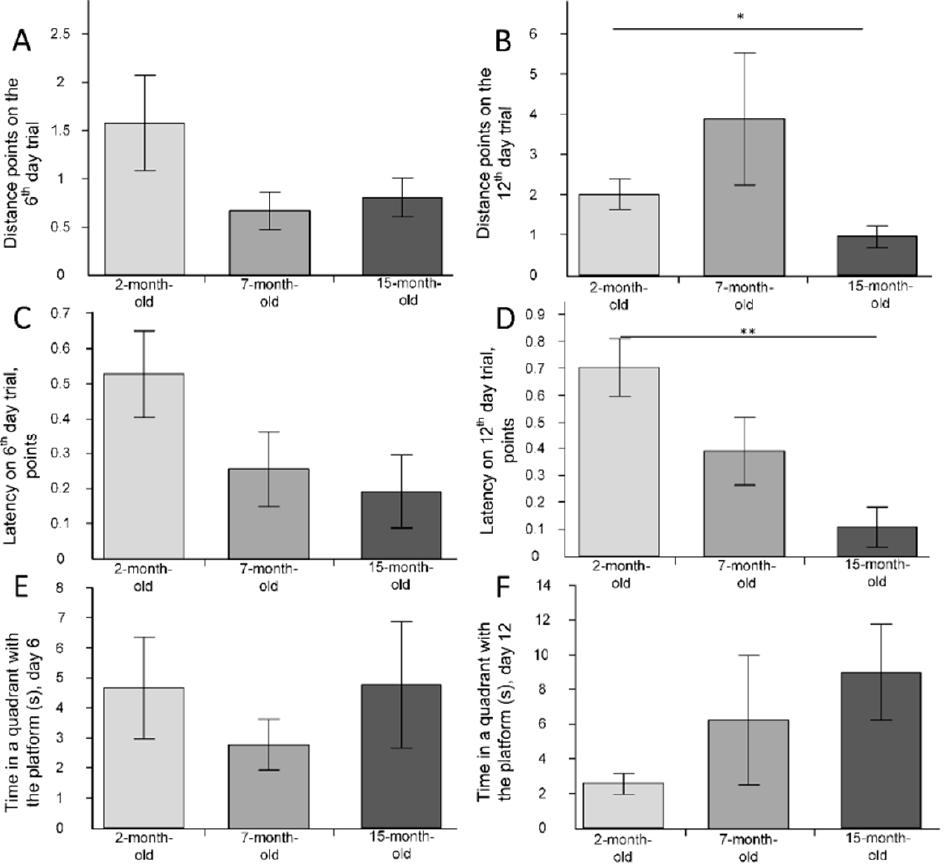
Figure 6. The results of the Morris water maze for reference memory. ( A ) Distance points on the sixth trial day; ( B ) distance points on the twelfth trial day; ( C ) latency time points on the sixth trial day; ( D ) latency time points on the twelfth trial day; ( E ) time in a quadrant with the platform(s) on the sixth trial day; ( F ) time in a quadrant with the platform (s) on the twelfth trial day. * p < 0.05; ** p < 0.01 differences between age groups were statistically significant according to the Mann–Whitney test. The 2-month-old mice (n = 9), 7-month-old mice (n = 9), 15-month-old mice (n =